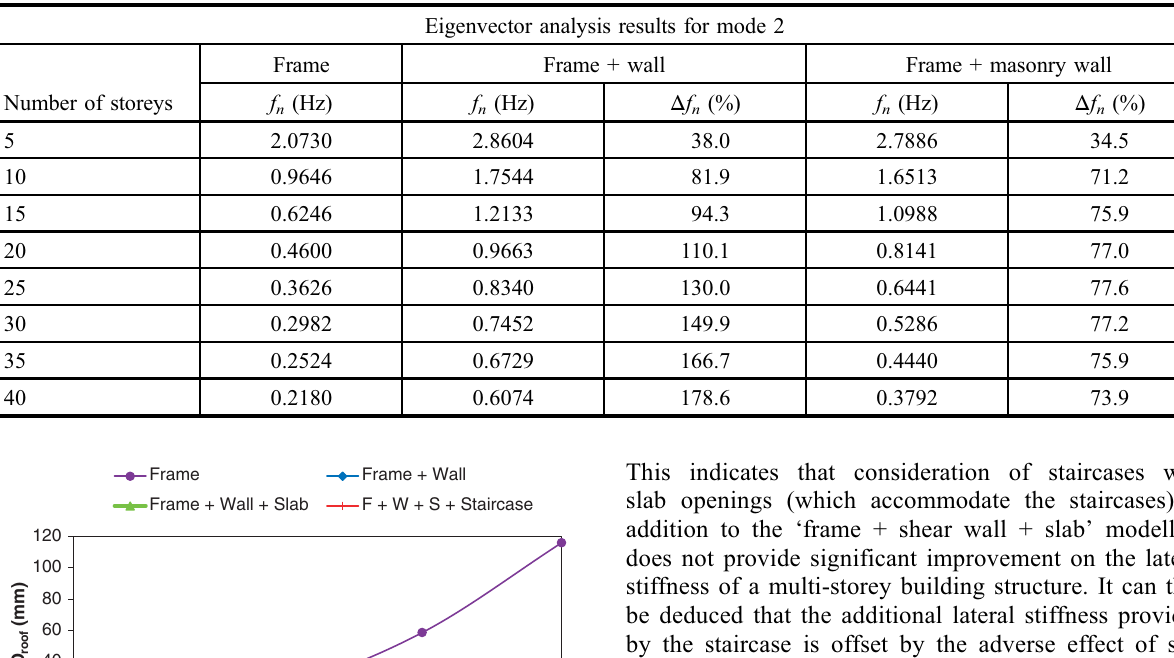
Table 3. Comparison of frequency considering masonry wall (second higher mode shape)